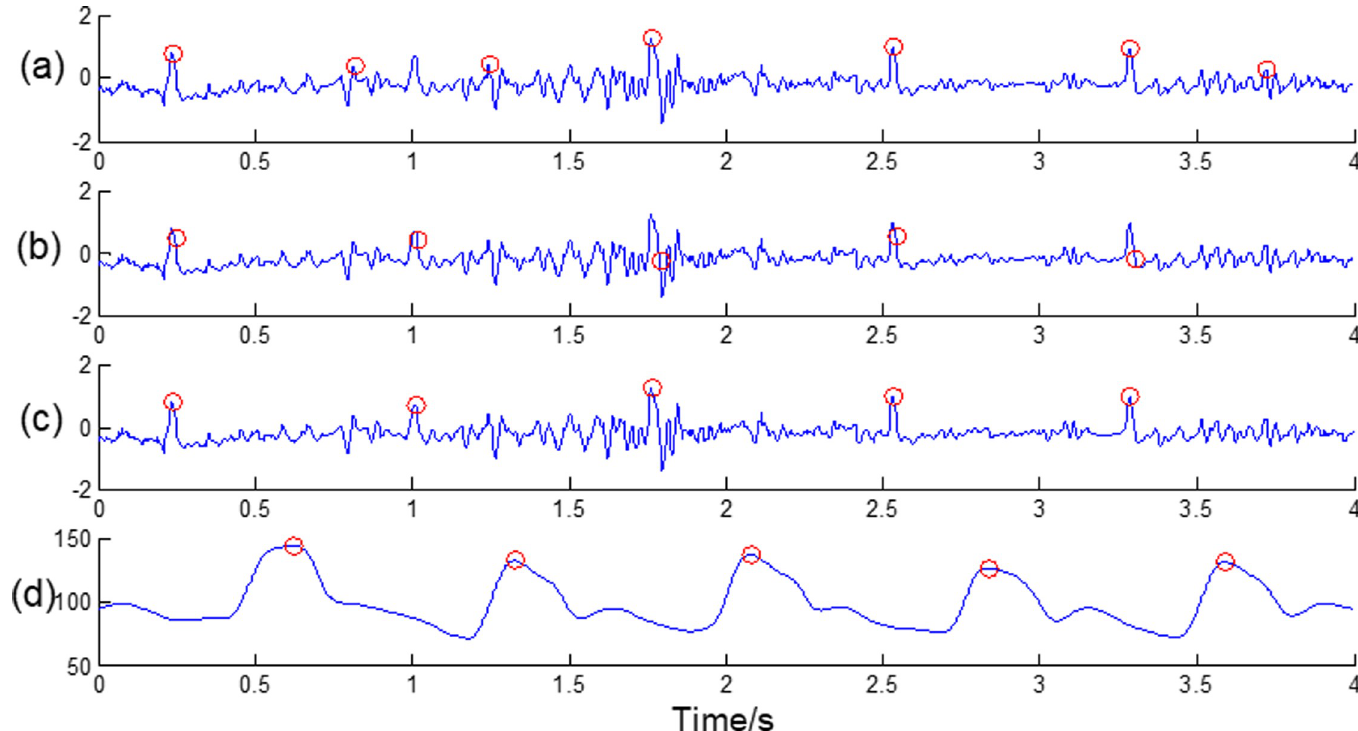
Fig 11. Comparison of detecting R-wave peaks independently and with the help of the BP signal. (a) Marks of the ECG R-wave peaks, which were detected independently. (b) Official marks of the ECG peaks. (c) Marks of the ECG peaks using our proposed fusion algorithm. (d) Marks of the BP peaks by our proposed fusion algorithm.